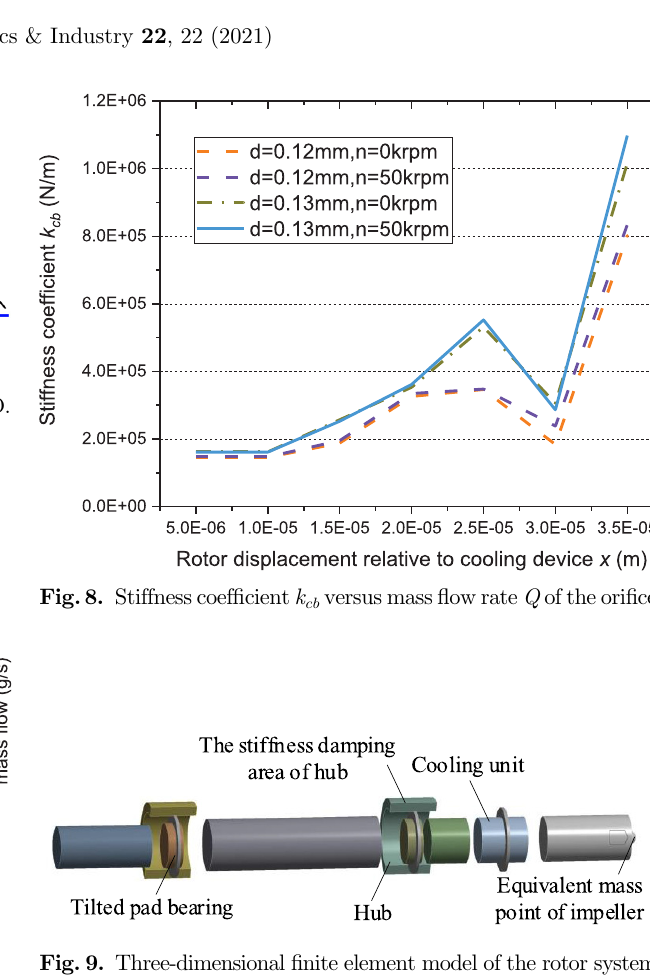
Fig. 7. Rotor displacement e c versus stiffness k cb .